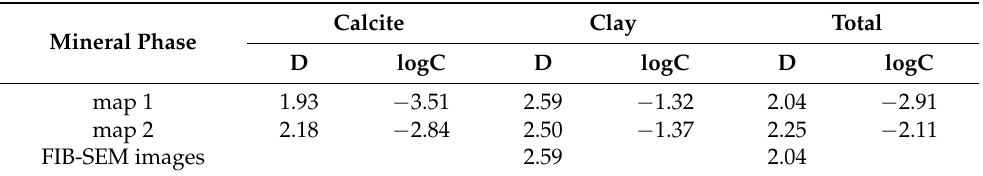
Table 3. Power law exponents (D) and constants (logC) for pores in calcite phase, clay mineral phase, and total